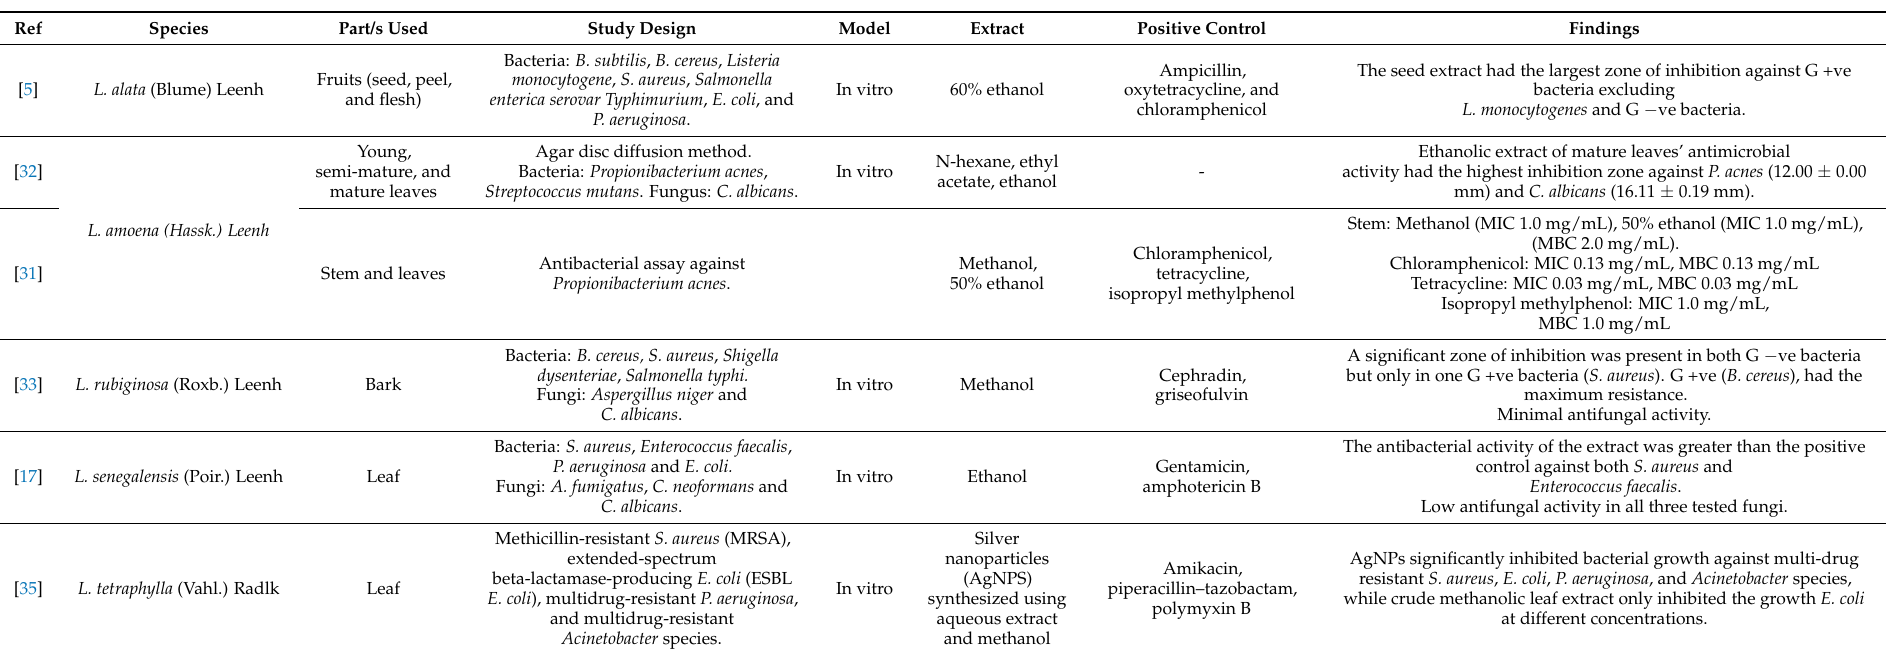
Table 5. Summary of the methods and antimicrobial activities of genus Lepisanthes